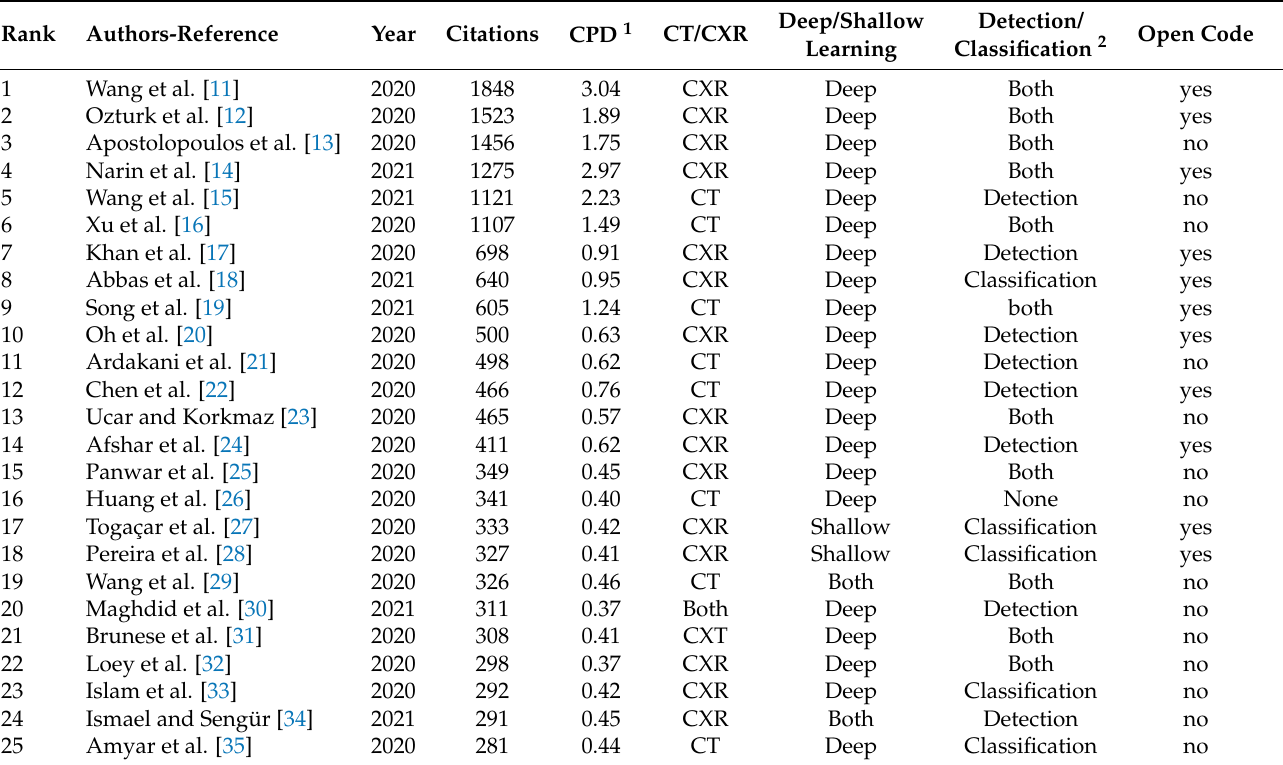
Table 2. Details about the 25 most cited